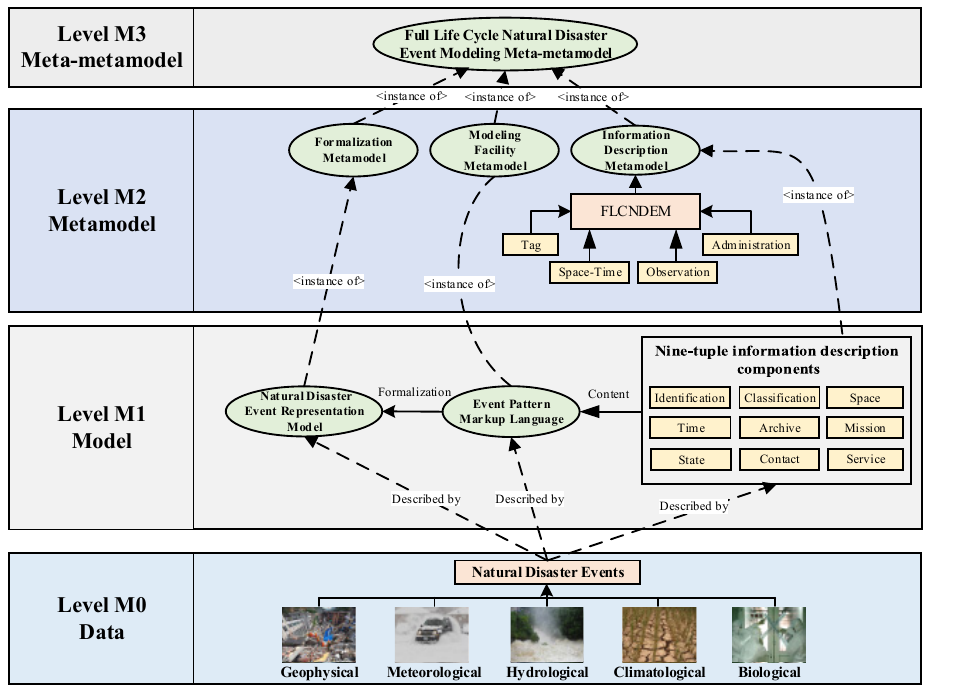
Figure 1. The four-level meta-object facility (MOF) architecture for the full life cycle natural disaster event metamodel